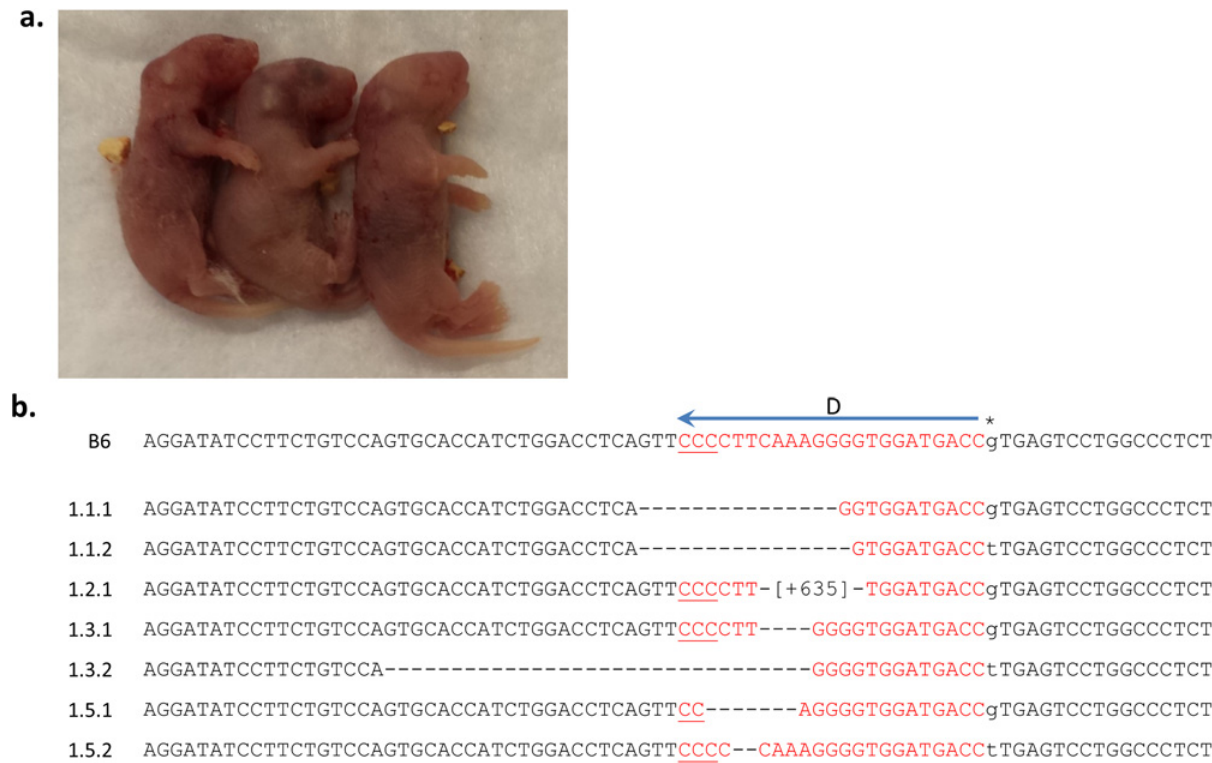
Figure 2. Successful genome editing of Tyr is evident on the day of birth and confirmed by DNA sequencing. (a) Phenotypic results of guide B editing of B6xAB6 fertilized eggs (Experiment 1) resulted in loss of eye pigmentation in two of three pups photographed on day 1 after birth, whereas one pups appeared unaltered (middle pup). Since sequencing analysis was not pursued in these pups, a disruptive indel on the AB6 allele and/or an in-frame indel on the B6 allele could also result in the same phenotypic finding. The mice in Experiment 1 did not survive because the cage housing the pups from guide B was flooded while pups from guide D were cannibalized by the mother. (b) Sequencing results of guide D editing from Experiment 1 are shown here. The Tyr alleles from guide B targeting were not analyzed. The B6 allele is indicated with the position of guide D as in Fig. 1. Mice are numbered with the following convention: (experiment#.mouse#.allele#). Mouse 1.1 (in-frame deletion on the B6 allele) and mouse 1.4 (no indels observed) had black eyes while the remaining mice had pink eyes at birth. Sequencing results from unaltered Tyr alleles are not shown. Deleted nt (-). Inserted nt in brackets.